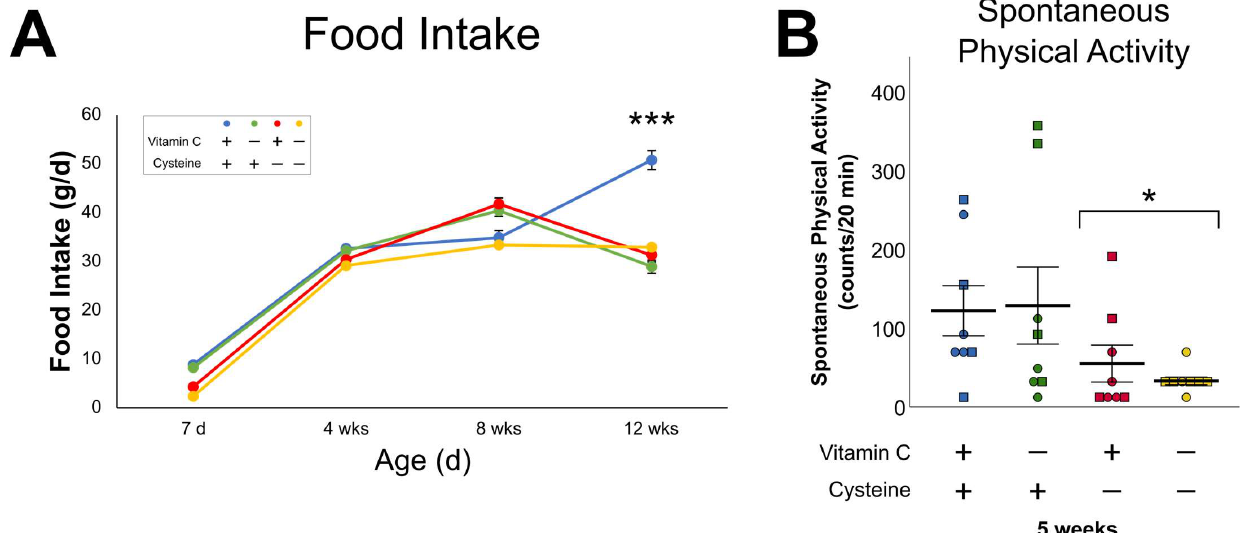
Figure 1. Food intake in animals at weeks 1, 4, 8, and 12 of life and spontaneous physical activity at 5 weeks of life. ( A ): Food intake evolved differently in animals according to the neonatal diets. Controls and double deficient animals evolved linearly (r 2C = 0.76; r 2DD =0.65), while vitamin C deficient and cysteine deficient animals fitted in a quadratic model (r 2VCD =0.45; r 2CD =0.41). The food intake is significantly decreased in all deficient animals at 12 weeks of age. ( B ) Spontaneous physical activity at 5 weeks was significantly decreased in cysteine deficient animals. Mean ± SEM. Circles: male animals; squares: female animals; *: p < 0.05; ***: p < 0.001.